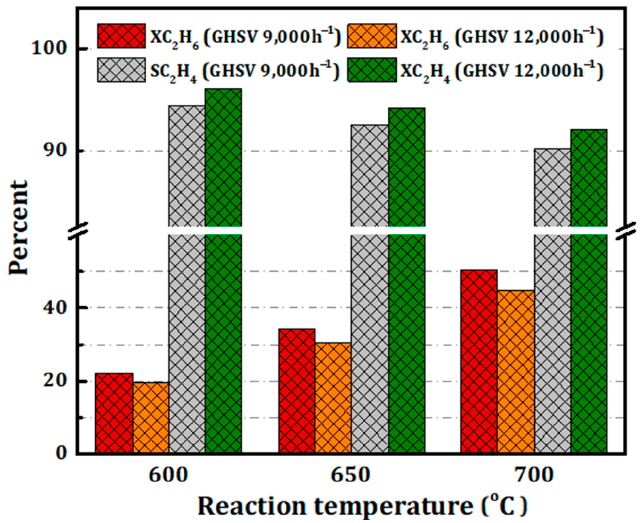
Figure 8. Effects of GHSV on the conversion of ethane and selectivity of ethylene for the Cr(8)/MOS catalyst at different temperatures.